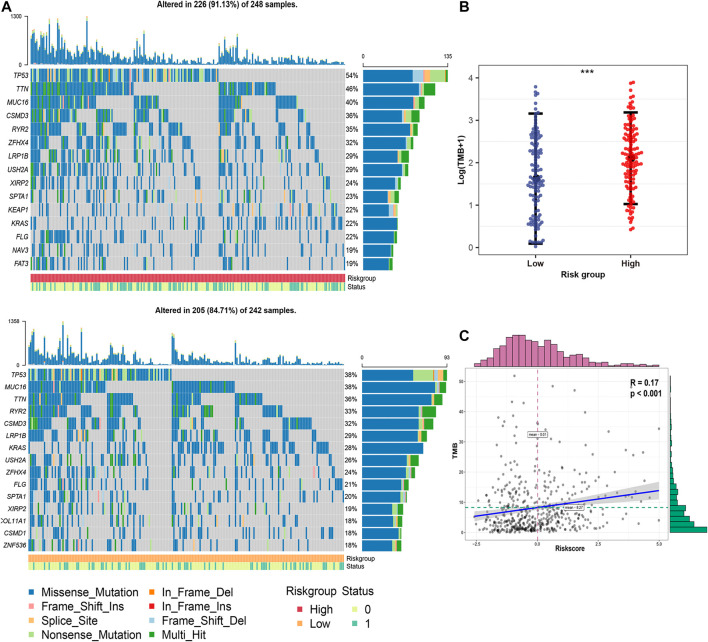
Genomic mutation profiles and TMB characteristics of different risk groups. (A) Distribution of frequently mutated genes in different TCGA-LUAD subgroups. The upper bar plot shows the TMB for each patient, whereas the left bar plot indicates the gene mutation frequency in different risk groups. The survival status of each patient is shown in the annotation bar. (B) Comparison of TMB between different subgroups in the TCGA-LUAD cohort. The whiskers embrace 1.5 times the interquartile range. ***p < 0.001. (C) Correlation analysis between TMB and FRRS in the TCGA-LUAD cohort.